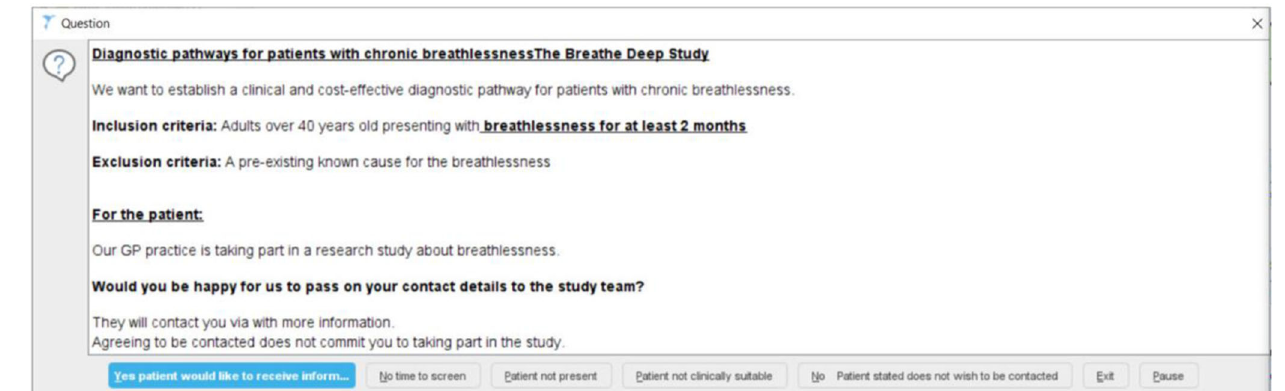
Fig. 1 Opportunistic Approach (Strategy 2). Electronic template triggered on consultation with the GP.